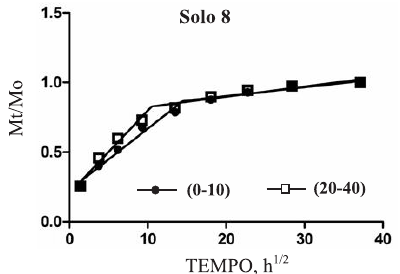
Figura 4. Cinética de liberação de Pb [equação parabólica de difusão (Mt/Mo = a + kt 1/2 )] das amostras de solo contaminadas pela passagem das águas pluviais de lavagem da fábrica, em área localizada no município de Adrianópolis- PR.